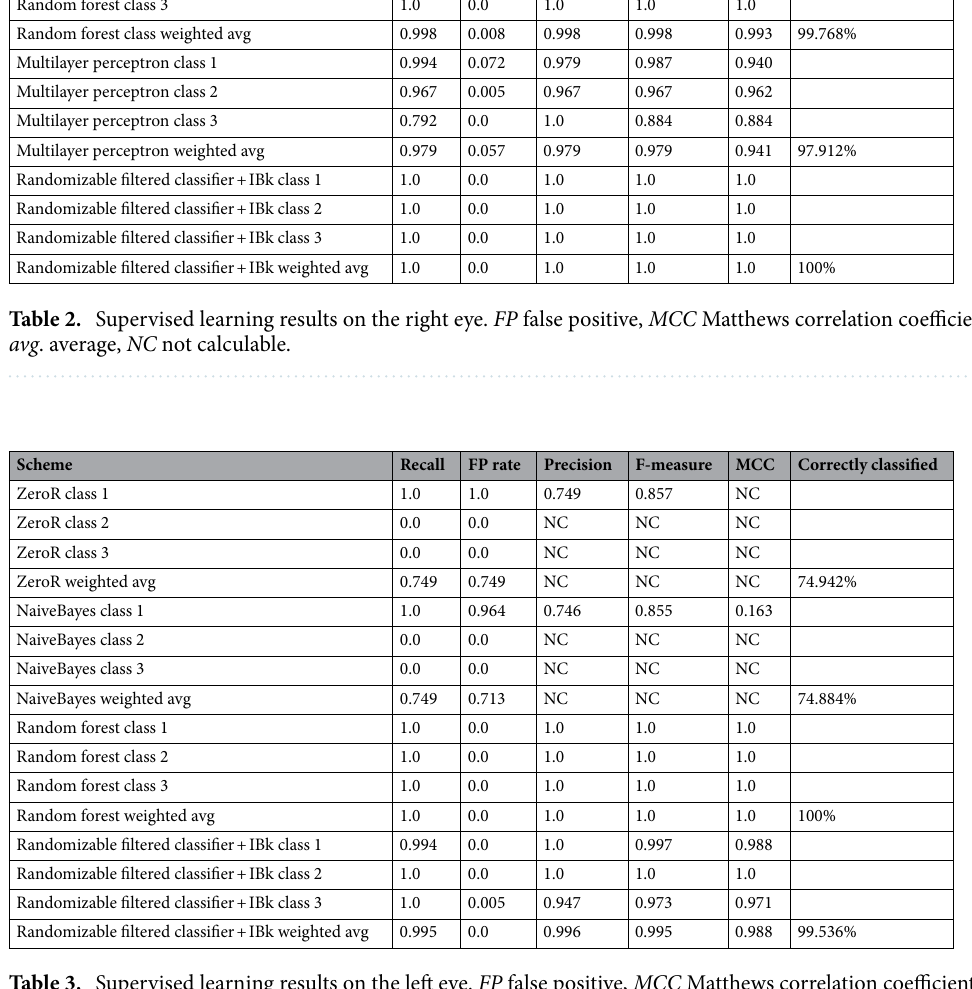
Table 3. Supervised learning results on the left eye. FP false positive, MCC Matthews correlation coefficient, avg . average, NC not calculable.